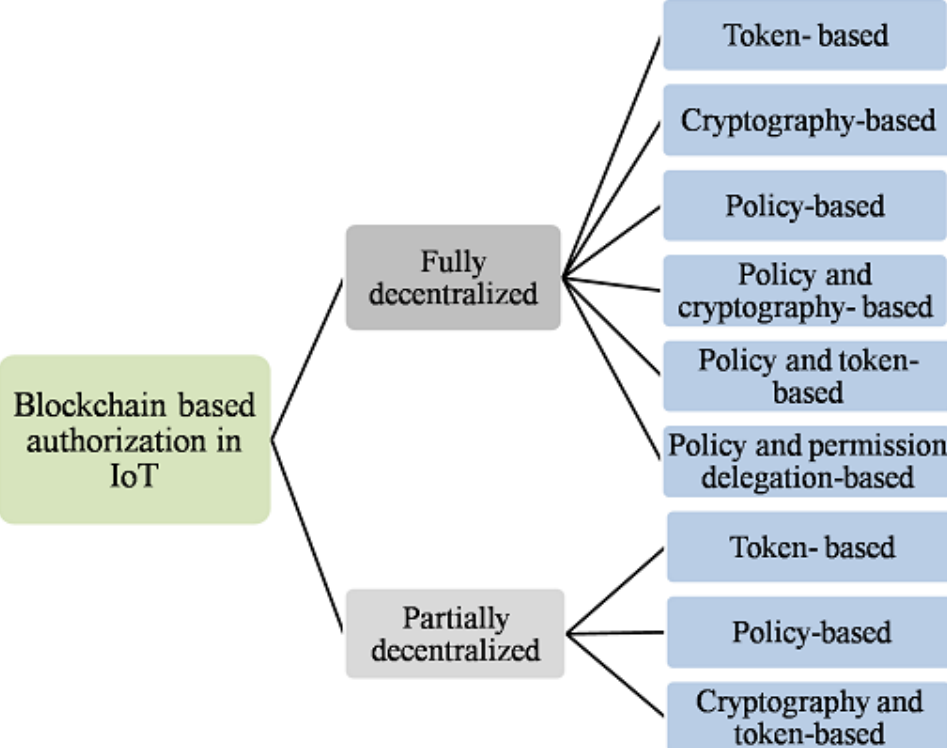
Figure 7. Taxonomy of authorization based on blockchain technology in